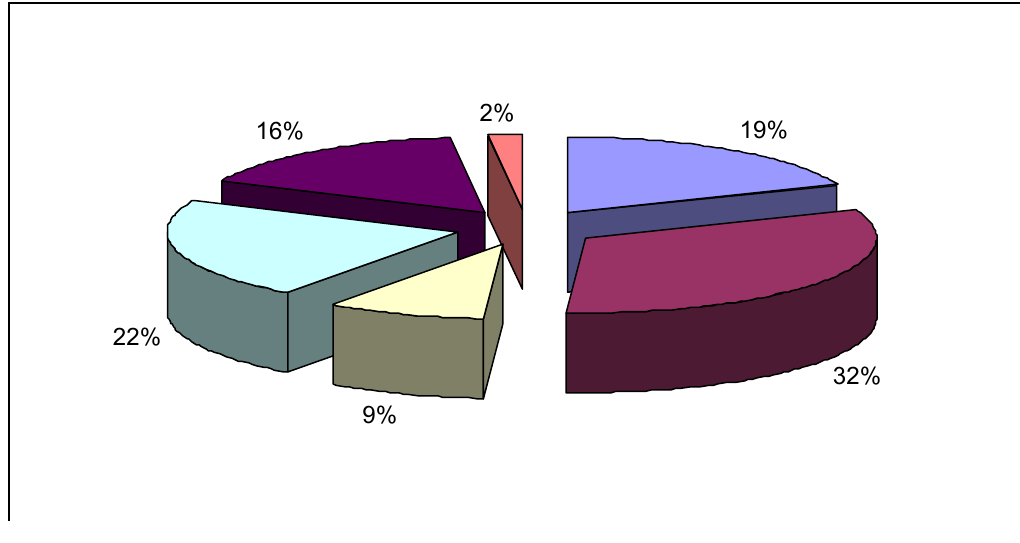
Fig. 1. Correlation of different orientation blocks in methodic of perfection of future specialists’ professionally important coordination